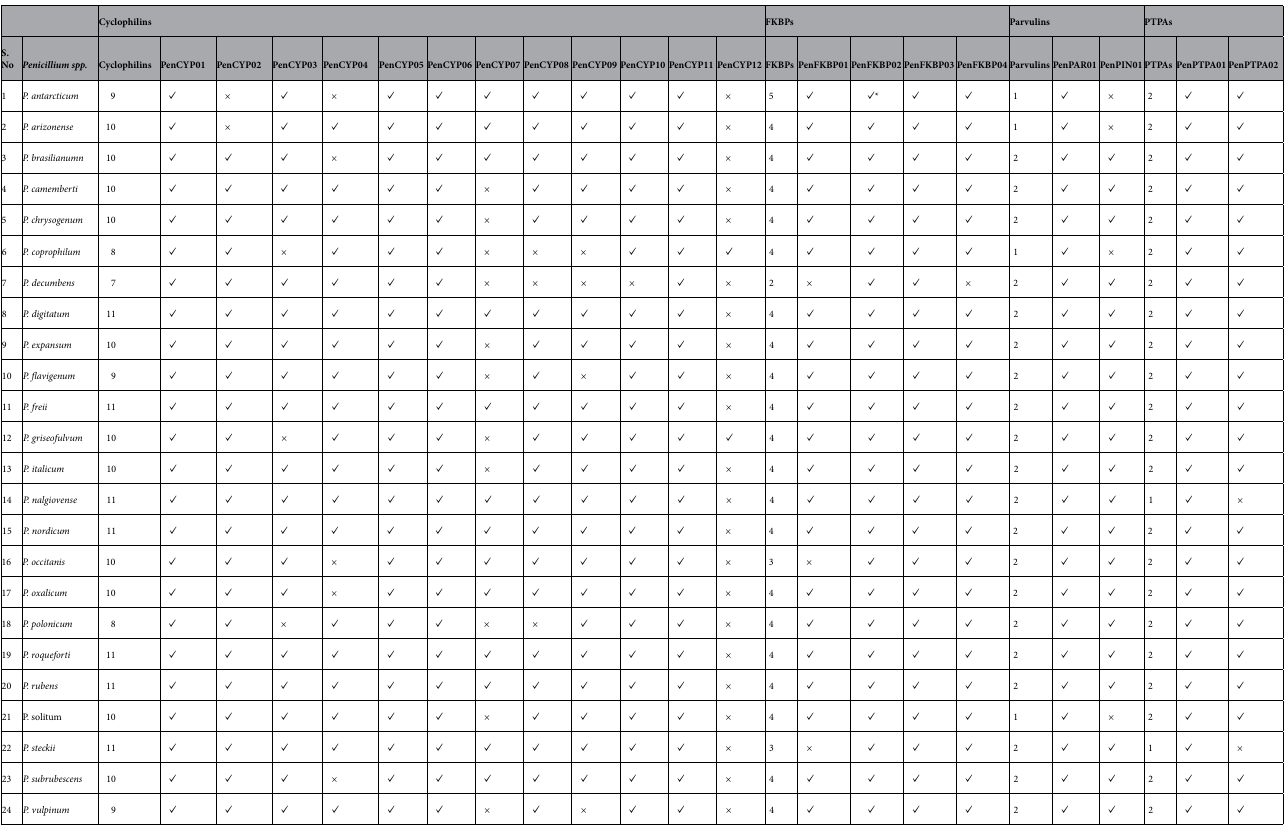
Table 2. Representation of cyclophilin, FK506-binding protein (FKBP), parvulin and protein phosphatase 2A activator (PTPA) orthogroups in different Penicillium spp. ×: absent; ✓ : present; *: two